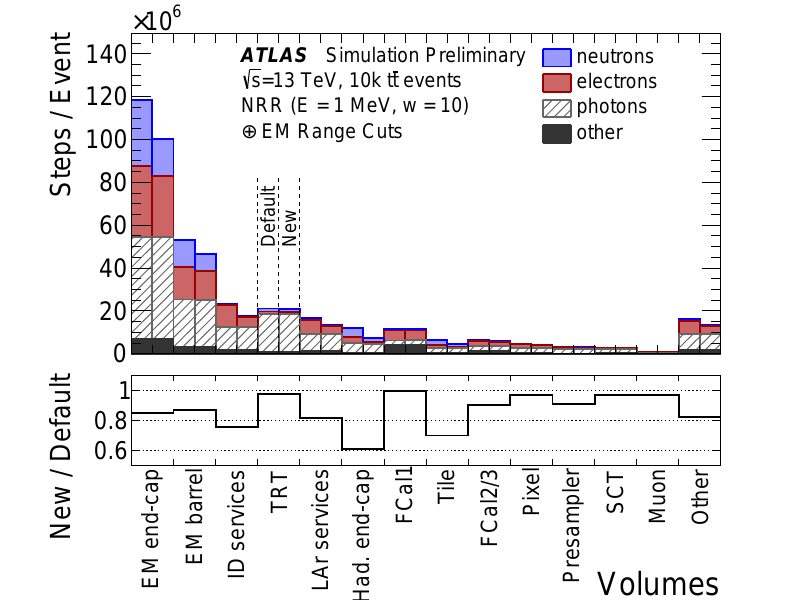
Figure 4: Number of Geant4 steps per event for various ATLAS detector volumes. Left col- umn in each section represents the default setup and the right column represents the default setup with both improvements (NRR and EM range cuts). ‘FCal1’ includes the first (elec- tromagnetic) module of the forward calorimeter and ‘FCal2 / 3’ includes the subsequent two hadronic modules. ‘ID services’ includes ID services and the beam pipe. ‘LAr services’ includes LAr services and LAr cryostats. ‘Other’ includes all other particles and all other volumes that are simulated. Figure taken from ref.